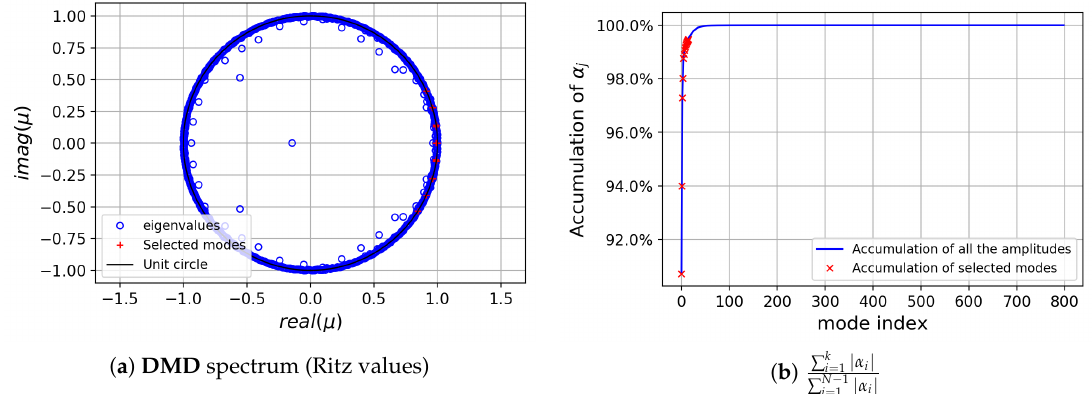
Figure 7. Re D = 60 cylinder flow: Dynamic Mode Decomposition ( DMD ) spectrum.